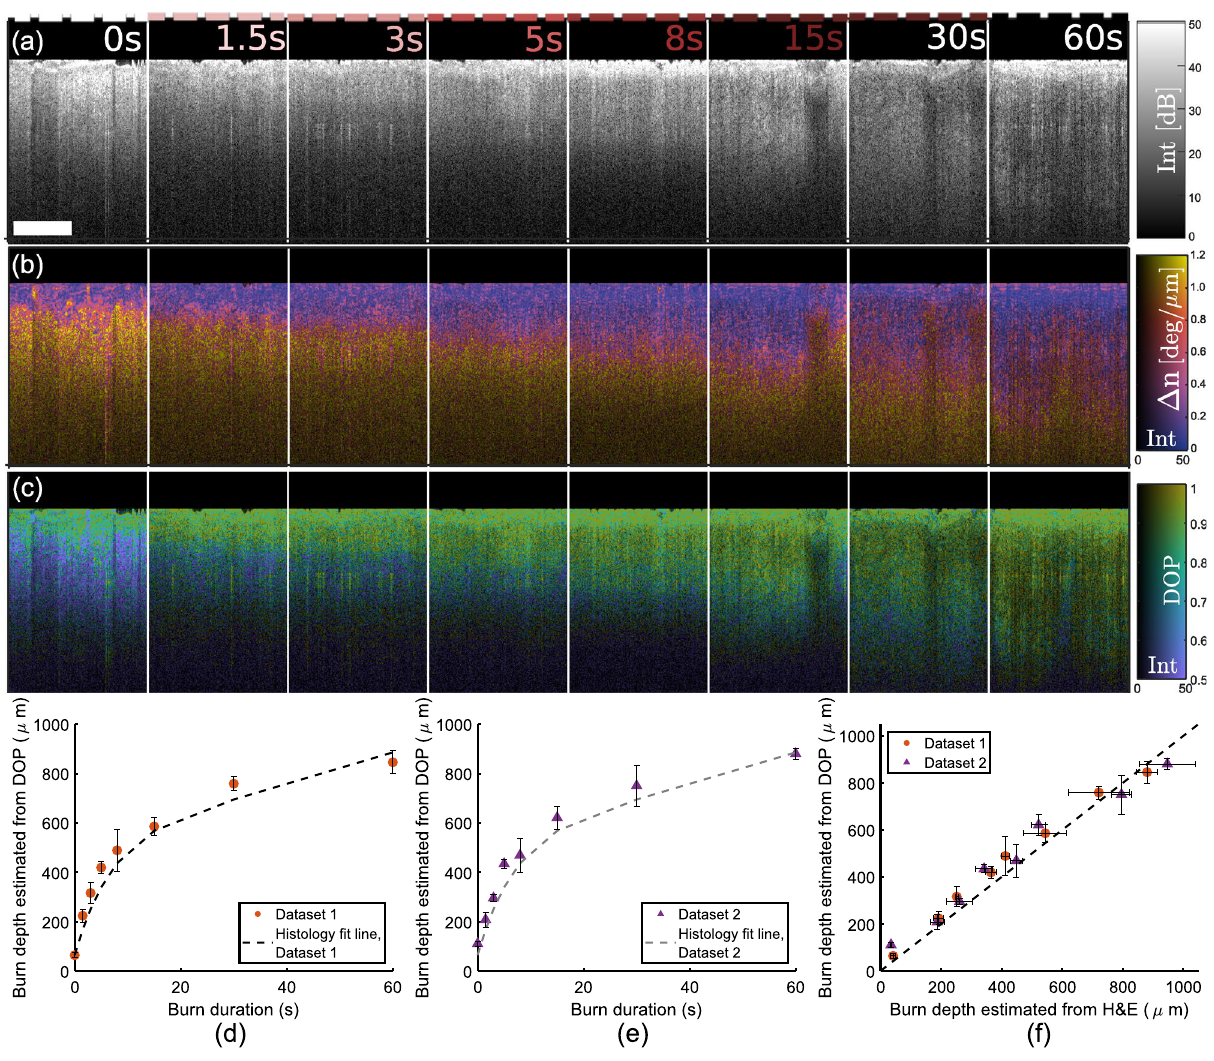
Figure 4. A representative cross-sectional OCT intensity image ( a ), birefringence map ( b ), and DOP map ( c ) is shown for a representative tissue location for each induced burn duration. DOP-based burn depth estimation results, averaged throughout each burned tissue volume, are plotted against histology results from Fig. 3 for Dataset 1 ( d ) and Dataset 2 ( e ). Histology fit line is reproduced from Fig. 3i,j. DOP-based and histology-based burn depth estimates are compared for each Dataset ( f ). Scale bars = 0.5